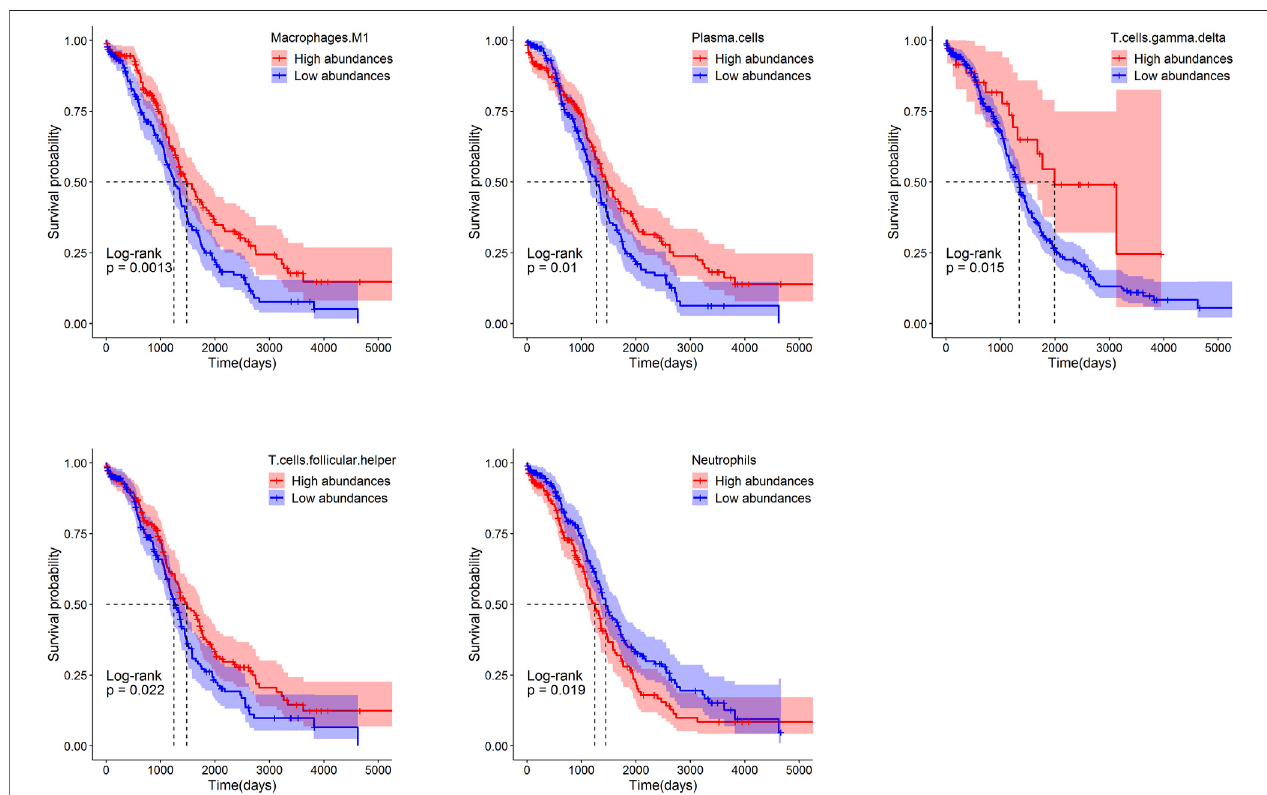
FIGURE 7 | Survival analysis of immune cells in ovarian based on the Kaplan-Meier